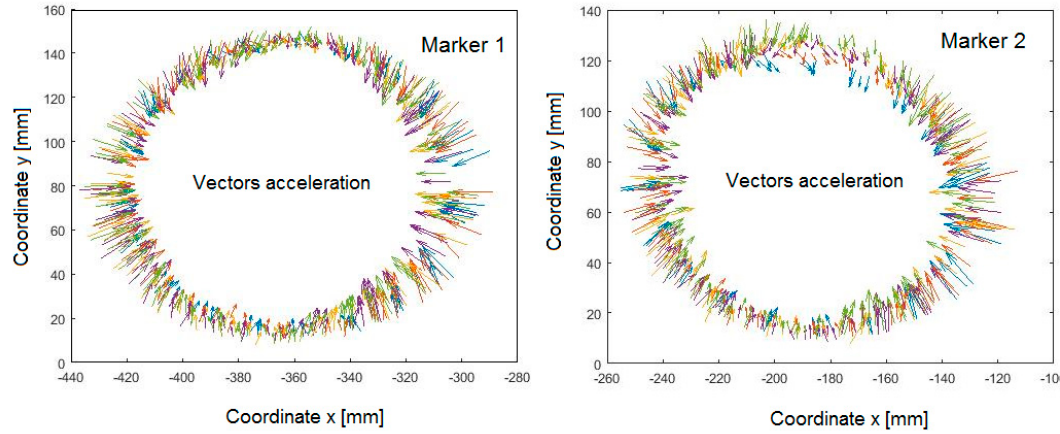
Figure 8. Acceleration of markers 1 and 2. The measurements for one rotation of the shaft have the same color. Table 2. Values of the velocity of markers 1 and 2 .